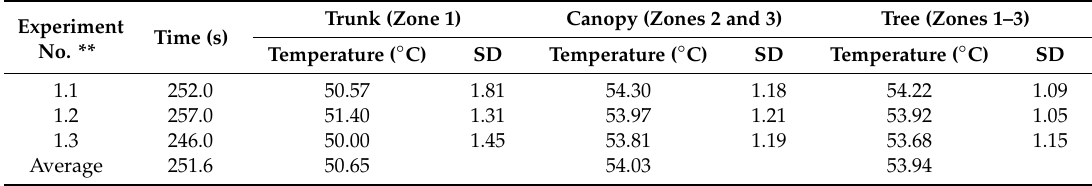
Table 4. Time to reach the desired temperature* of 54 ◦ C for treatment.